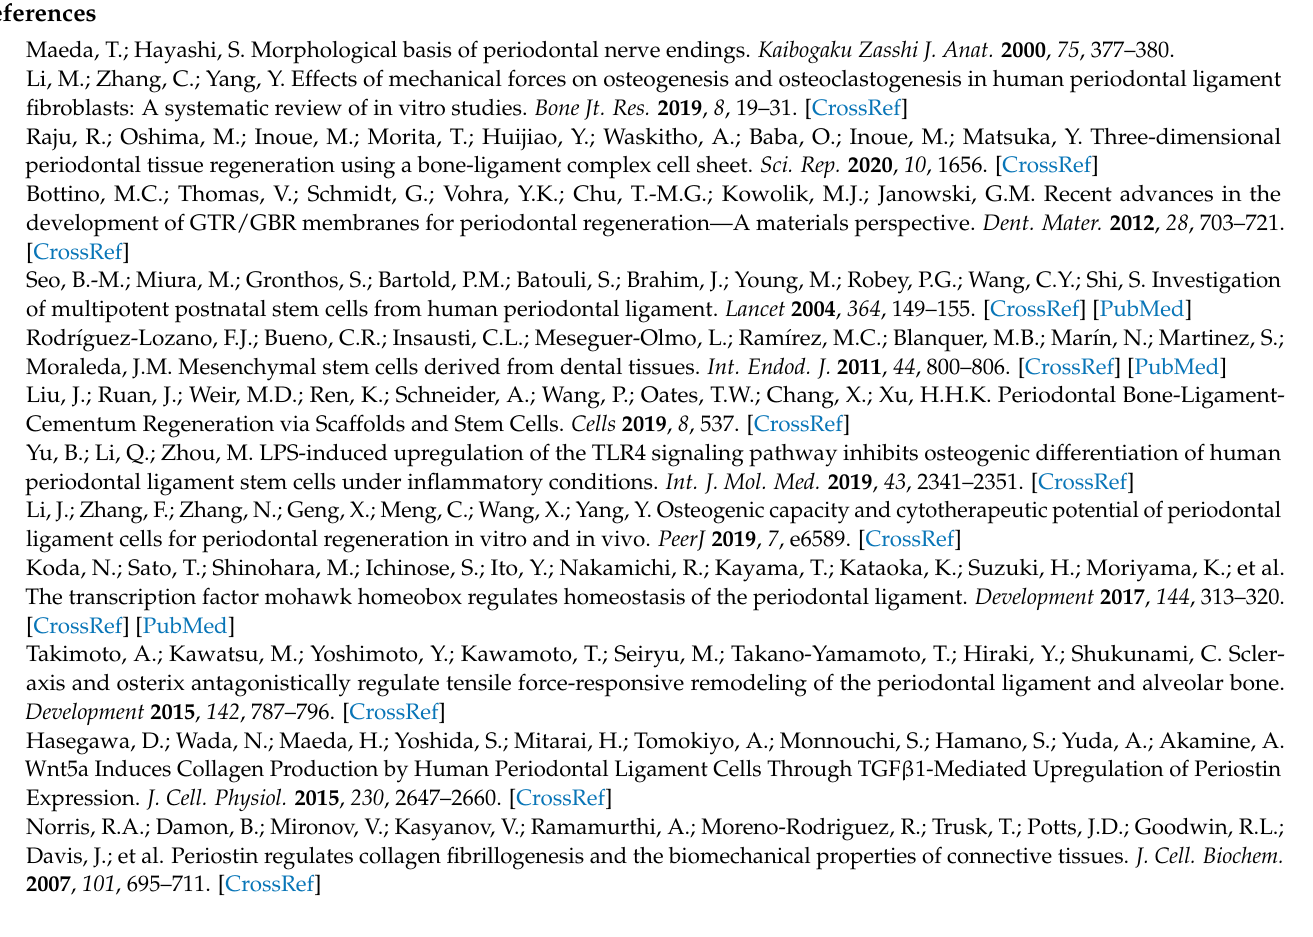
Figure S2: Results of ALP activity measurement when HPLFs were cultured for 21 days. HPLF was cultured in ( − / − ) and (+/ − ) medium and ALP activity was assayed. On the 14th day of culture, ALP activity was significantly increased in the ( − / − ) medium. In (+/ − ) medium, no change in ALP activity was observed from the 5th day of incubation, whereas in ( − / − ) medium, ALP activity continued to increase as a function of time. Error bars; mean ± S.D, ** p <0.01, (n (cid:61) 3); Figure S3: Gene expression analysis by Real Time Quantitative PCR (Cementum related genes). The expression of CAP (Cementum attachment protein) gene was determined after 14 days of incubation of HPLF in each medium. There was no significant difference between the mediums. Data represent the means ± S.D; Table S1: The primers of